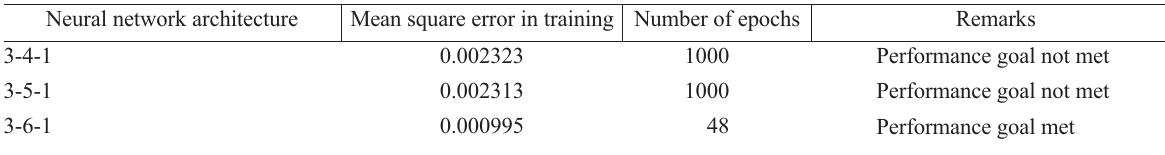
Table 3. The error of training for various neural